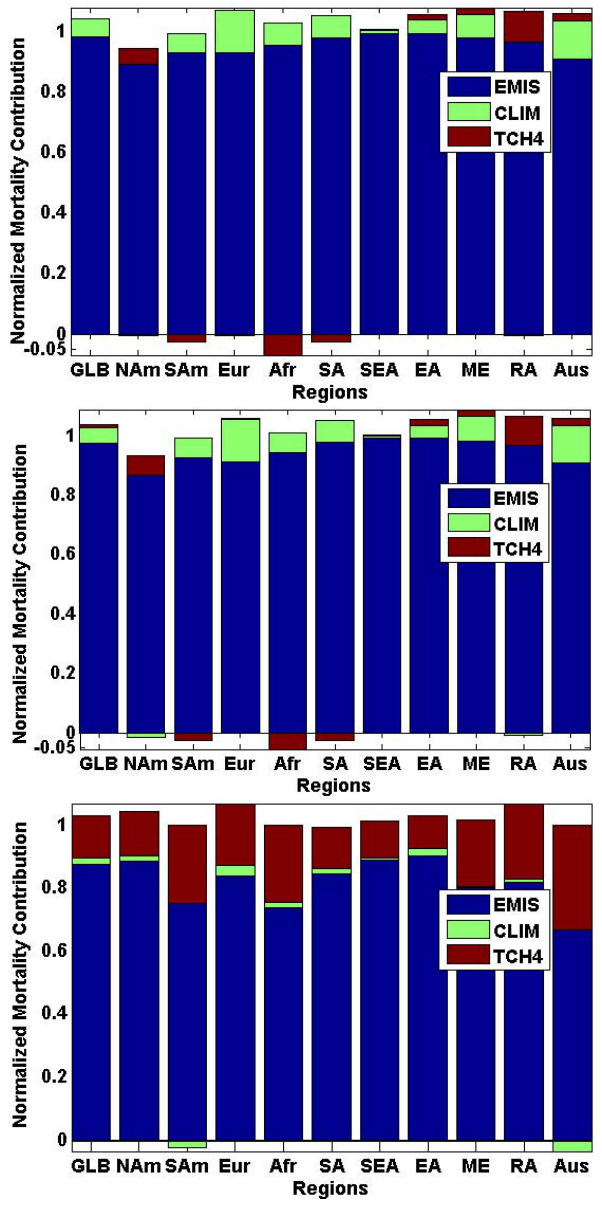
Fig. 6. Normalized Mortality Contribution of (a) cardiopulmonary and (b) lung cancer associated with surface PM 2 . 5 and of (c) respi- ratory disease associated with O 3 over each region. Blue, green and dark red represent the impact of changes in emissions of short-lived species, climate change and the impact of CH 4 change on tropo- spheric chemistry, respectively. Labels on the x-axis represent the following regions: Global, North America, South America, Europe, Africa, South Asia, Southeast Asia, East Asia, Middle East, Rest of Asia, and Australia, as in Fang et al.